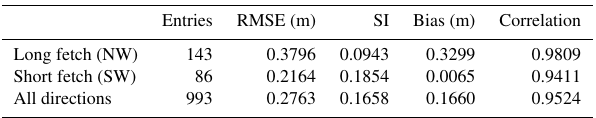
Table 4. Comparison of the data quality, organized by onshore and offshore flights, for Sentinel-3A SAR. Only measurements taken within the first 10km off the coast are used.